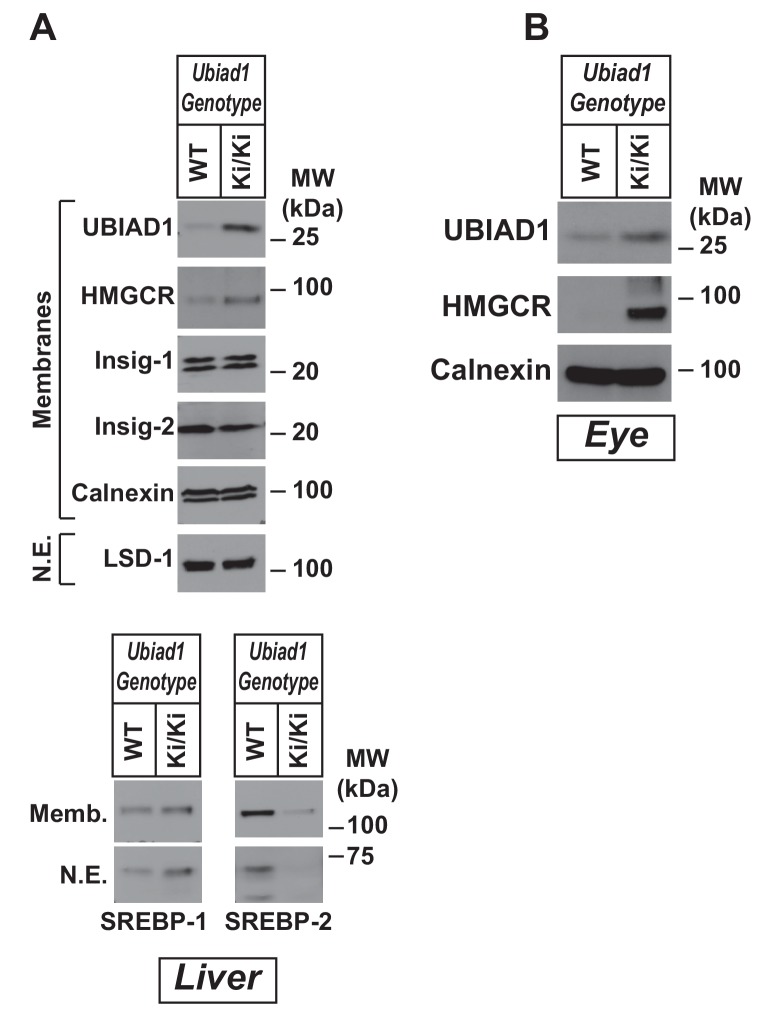
Accumulation of HMGCR protein in eyes and livers of WT and Ubiad1Ki/Ki mice.Female WT, Ubiad1WT/Ki, and Ubiad1Ki/Ki littermates of animals used in Figure 2 (six mice/group, 8–9 weeks of age) were fed an ad libitum chow diet prior to study. Aliquots of membrane (Memb.) and nuclear extract (N.E.) fractions from homogenized livers (A) and enucleated eyes (B) (50–80 µg of total protein/lane) were analyzed by immunoblot using antibodies against the indicated proteins. Although shown in separate panels, LSD-1 serves as a loading control for the nuclear SREBP-1 and SREBP-2 immunoblots in (A).